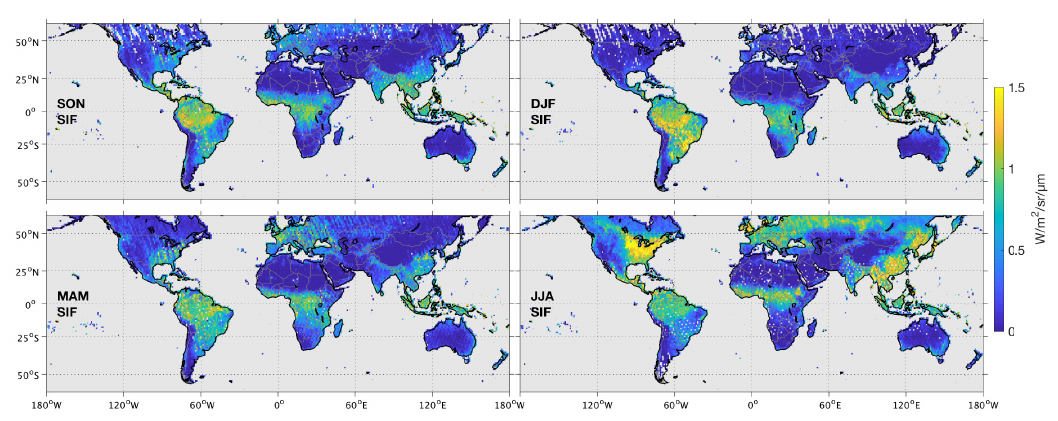
Figure 5. Seasonal OCO-2 solar-induced chlorophyll fluorescence (SIF) at 757 nm for different seasons (from September 2014 to August